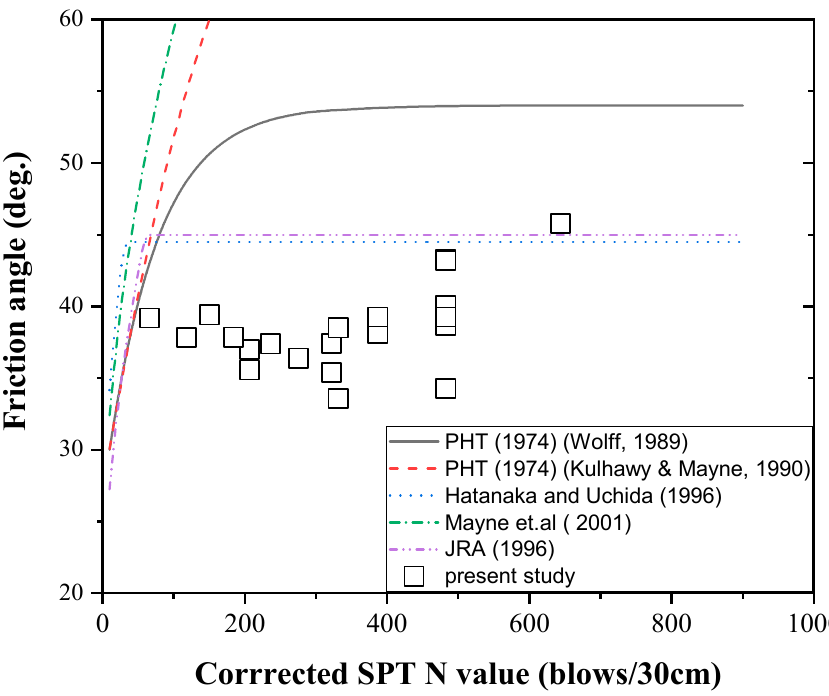
Figure 9. Comparison of friction angle with previously suggested correlation using the standard penetration test (SPT)-N value.